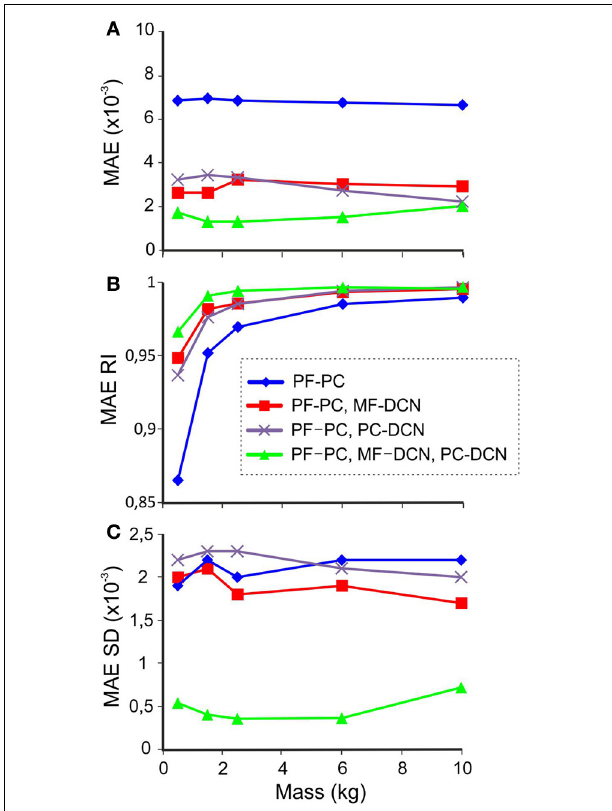
FIGURE 8 | Performance with different masses. In synaptic connections with fixed weights, the values correspond to the 10-kg set up to avoid saturation during manipulation of heavier masses. The last 100 of 1500 trials during learning processes were used for MAE estimation with different combinations of active learning rules at different masses. (A) MAE (B) MAE RI (1 is perfect error correction by the cerebellar action and 0 is no correction), (C) MAE standard deviation ( SD